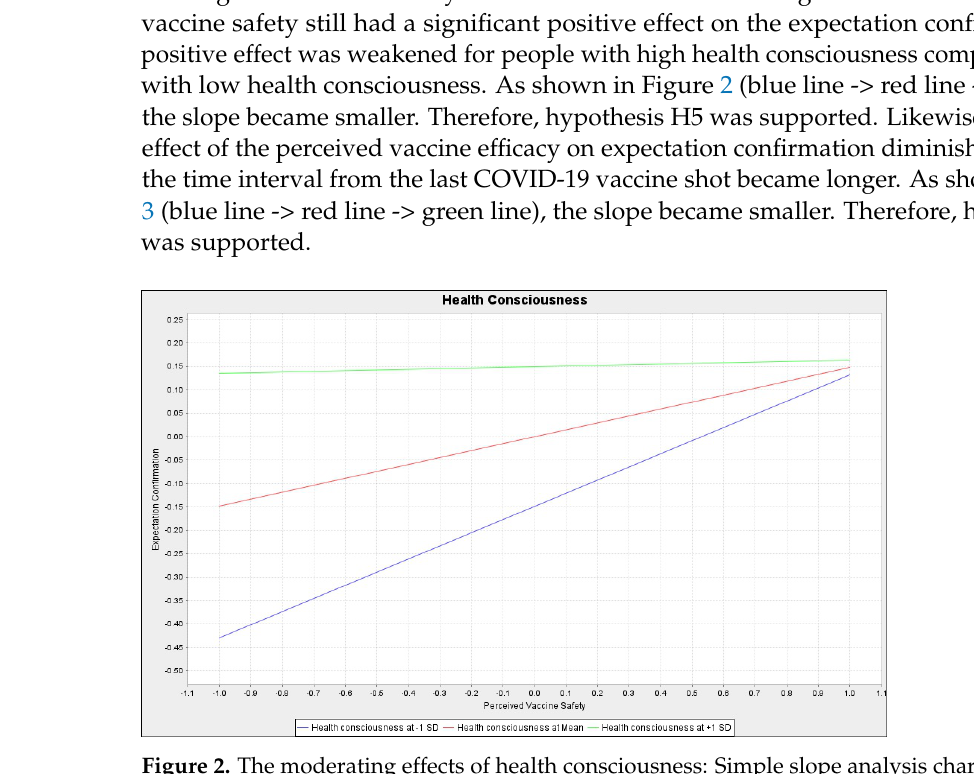
Figure 2. The moderating effects of health consciousness: Simple slope analysis chart.